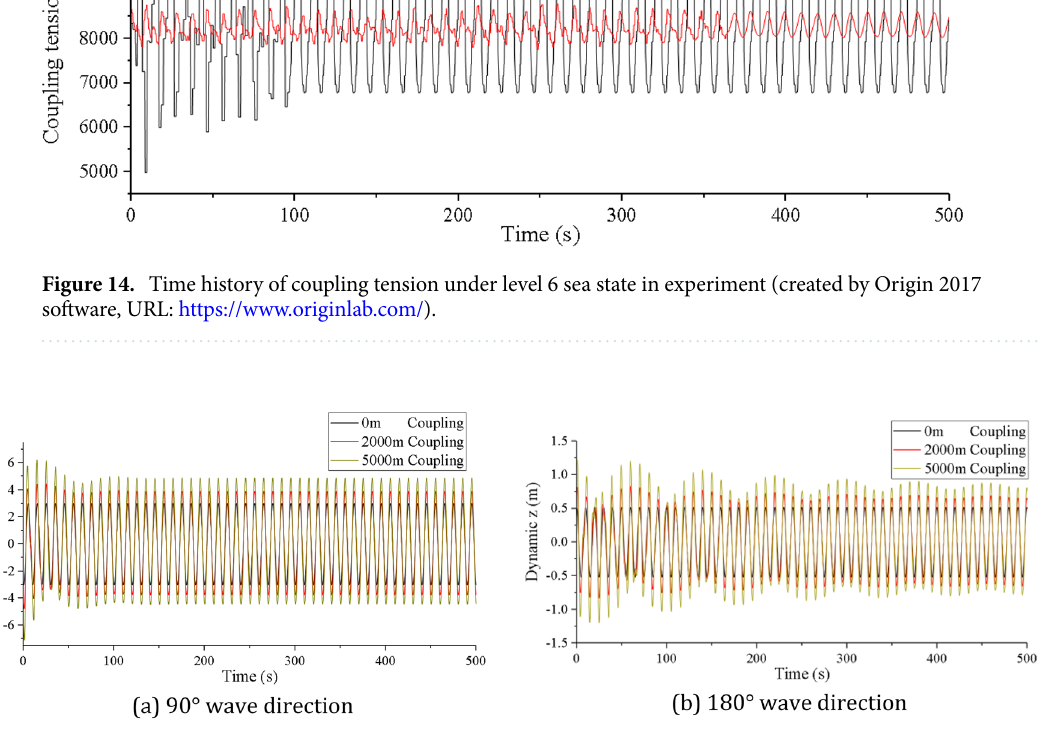
Figure 15. Time history of longitudinal vibration displacements of lifting pipe (created by Origin 2017 software, URL: https:// www. origi nlab. com/).